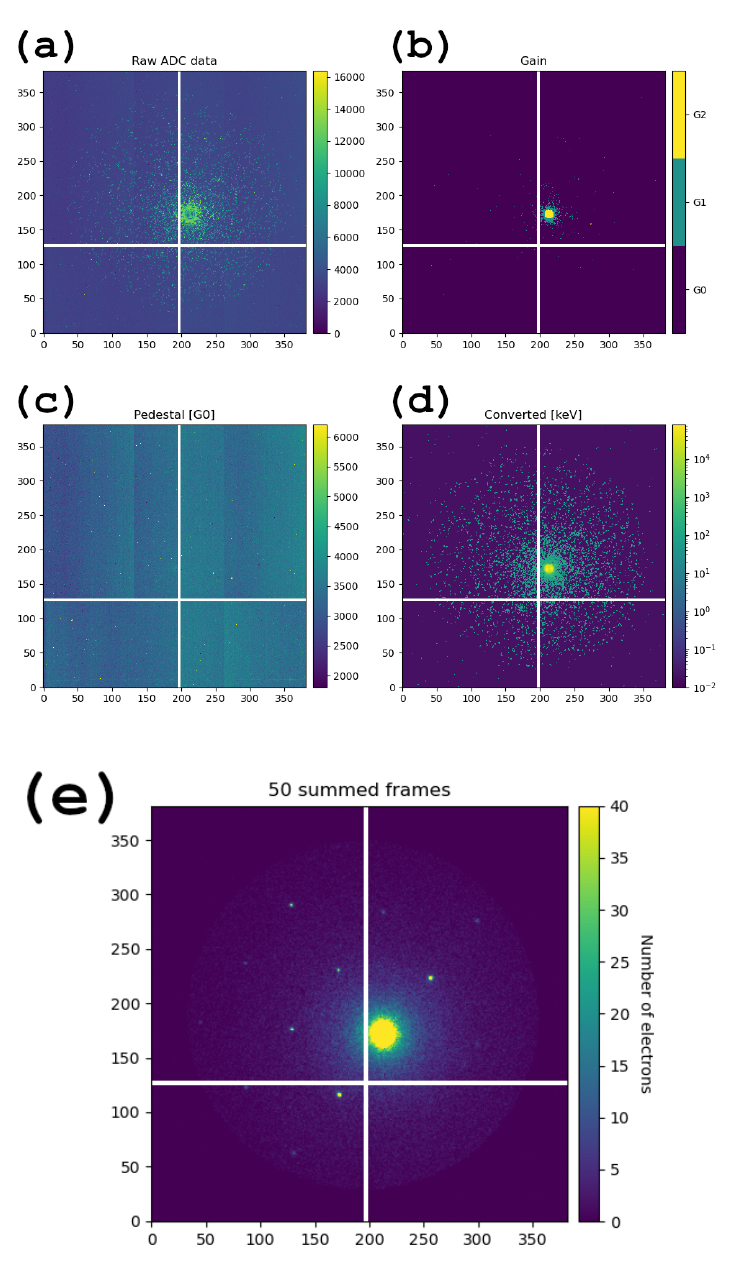
Figure 4. Albite data conversion and energy correction with the JUNGFRAU detector. ( a ) Raw data recorded in 1 ms, ( b ) gain levels per pixel, ( c ) pedestal map for gain level 0, ( d ) converted frame, ( e ) sum of 50 converted frames makes the diffraction pattern